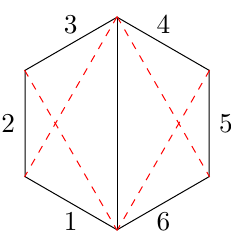
2 ) (1 , 2 , 3 , 6 , 5 , 4 | 1 , 2 , 3 , 4 , 5 , 6) , the black lines represent 6